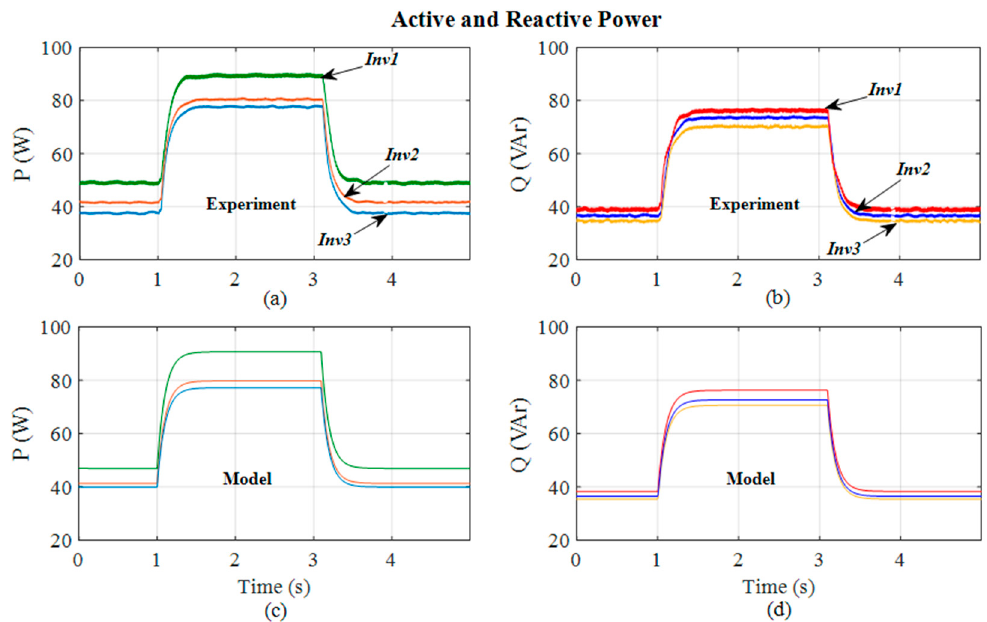
Figure 26. Step Response Comparison Between Physical Experiment and Mathematical Figure 26. Experimental results for the islanded microgrid.